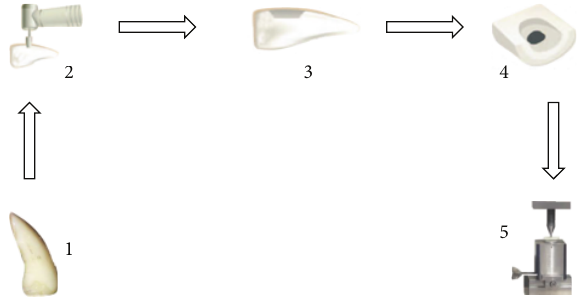
Figure 1: Schematic representation of the “push-out” test: (1) bovine incisor; (2) cavity preparation using standard cavity preparation appliance; (3) lateral view of the restored sample; (4) selective wear of the lingual surface and exposure of the bottom area of the restoration; (5) lateral view of the testing